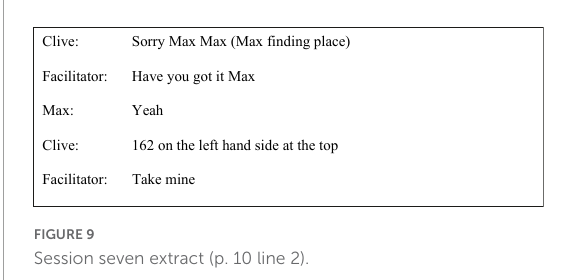
FIGURE9 Session seven extract (p. 10 line